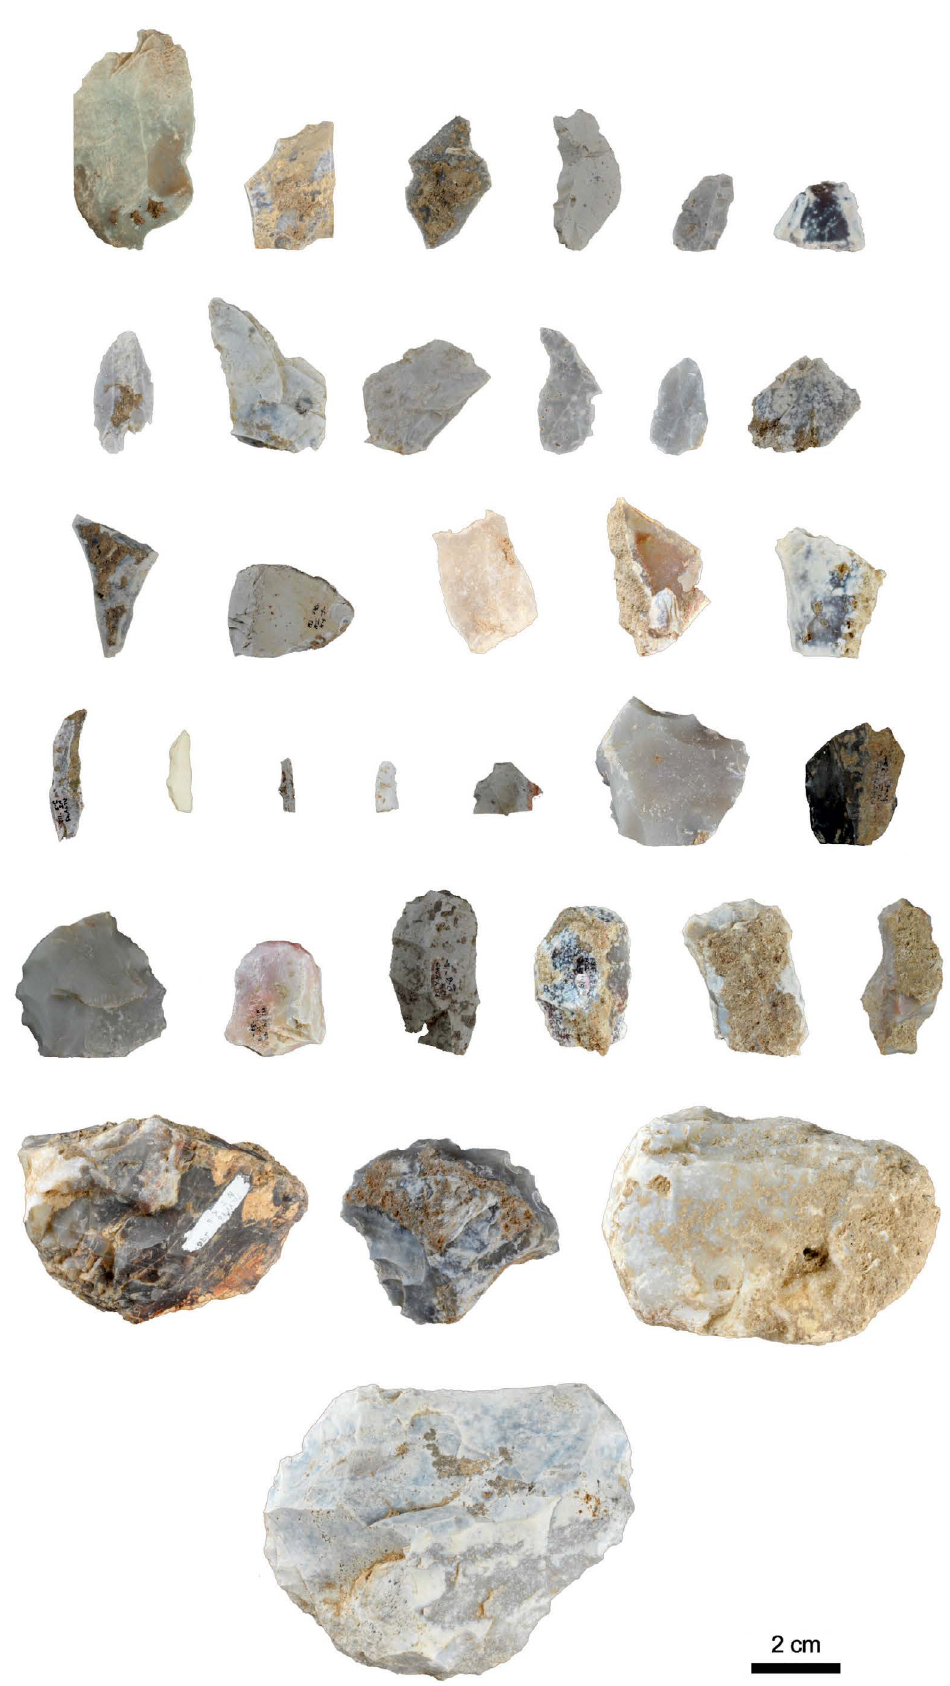
Figure 3. Sample of the lithic assemblage of the CIIA level at Picamoixons site. Flakes, blades, backed bladelets, denticulates, endscrapers and